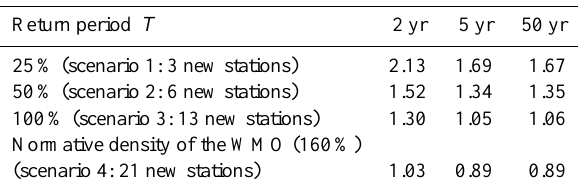
Table 5. Values of OF ref (T ) objective function obtained for inter- polation of a(T )